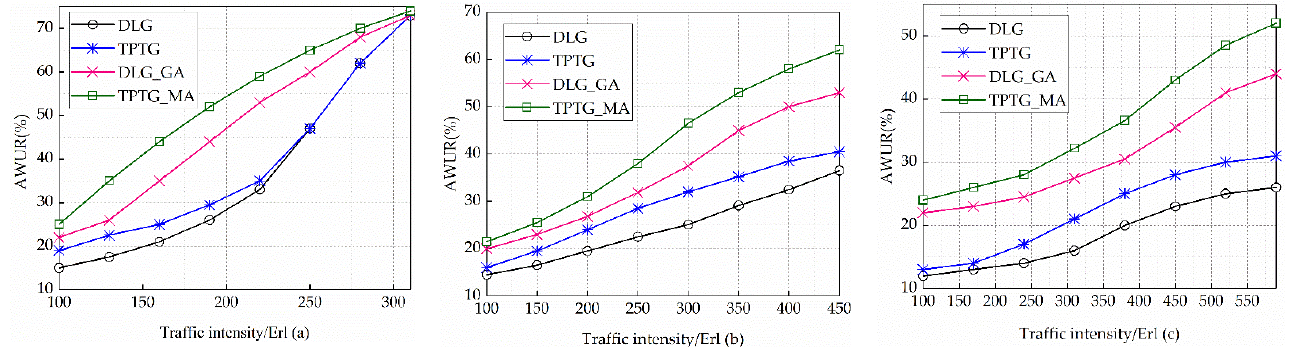
Figure 3. Comparisons of the AWUR between the DLG, TPTG, DLG_GA, and TPTG_MA under ( a ) 6-node topology, ( b ) 12-node topology, and ( c ) 22-node topology. ( a ) 6-node topology, ( b ) 12-node topology, and ( c ) 22-node